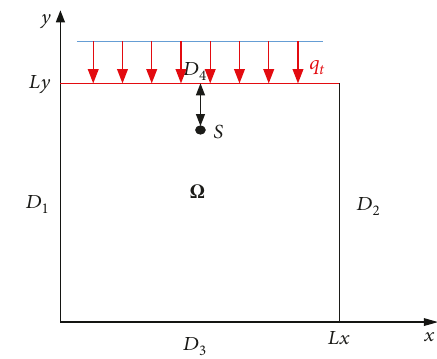
Figure 1: Two-dimensional unsteady plate heat conduction system.